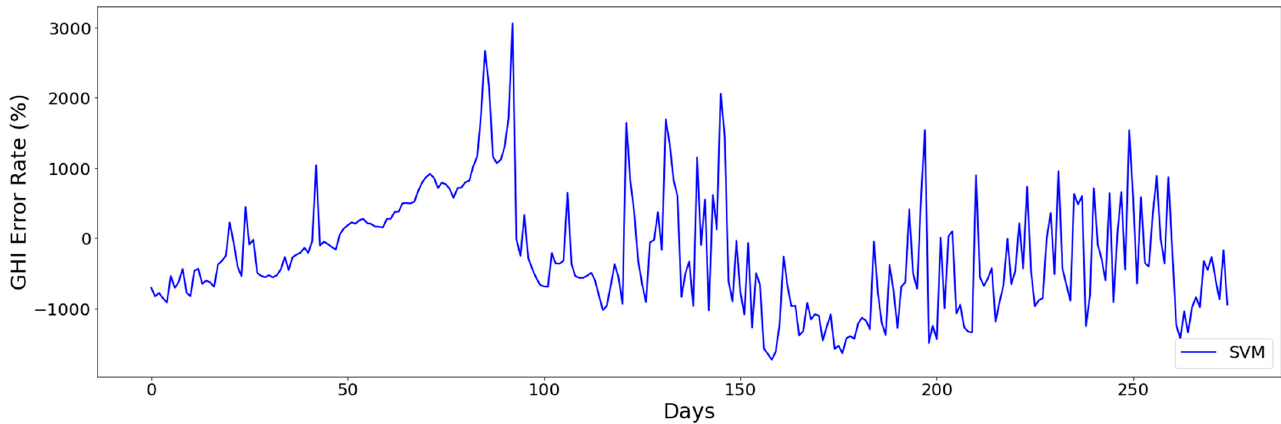
Figure 12. SVM error frequency rate.